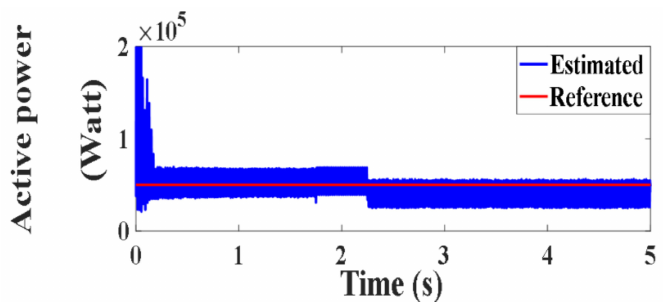
Figure 24. Active power under MPCC